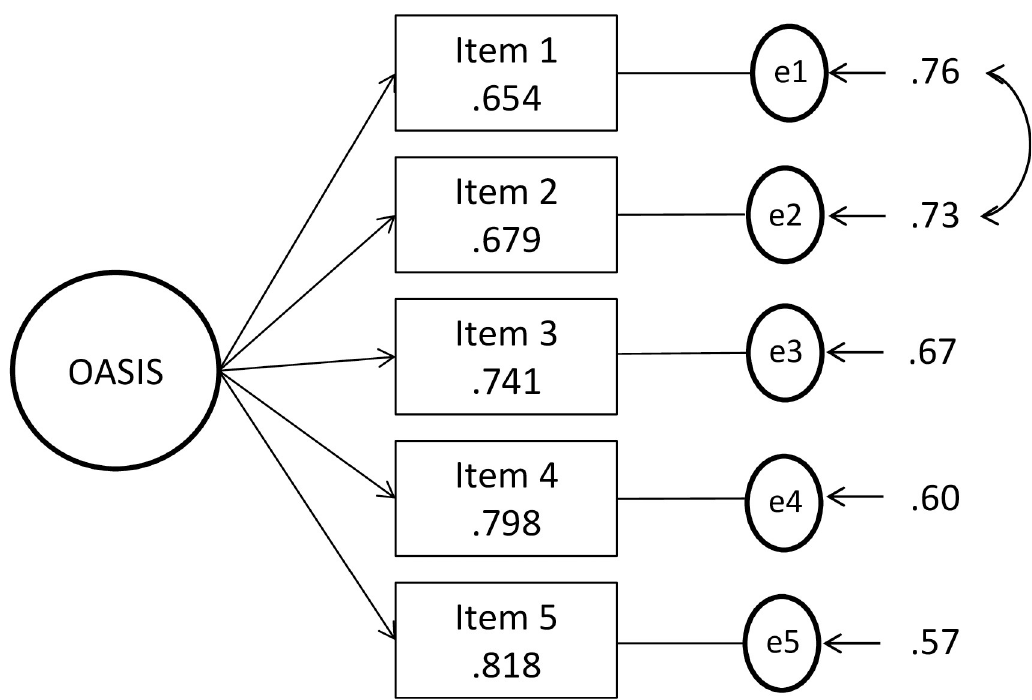
Fig 1. Confirmatory factor analysis (CFA) model. Rectangles are measured variables, the large circle is the latent construct, and small circles are residual variances. Factor loadings are standardized. All values are significant at p < .05. The solution specified correlated error variance between items 1 and 2.